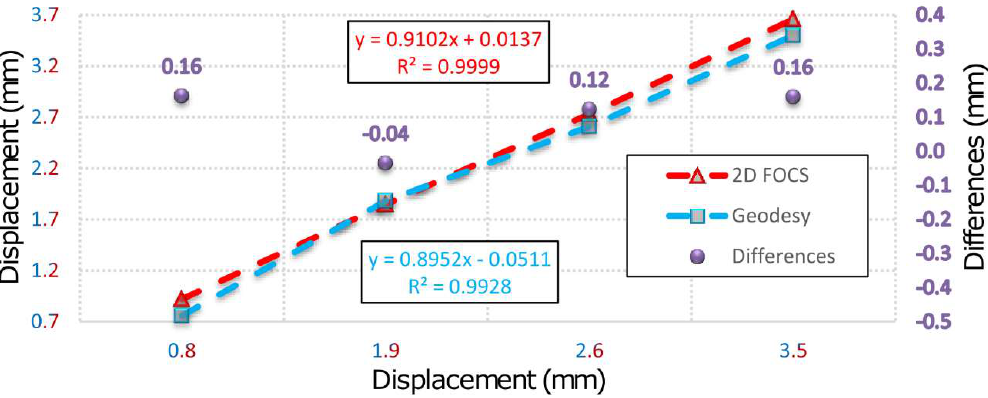
Figure 10. Results and differences of geodetic and 2D deflection sensor measurements for point 7 without zero series.